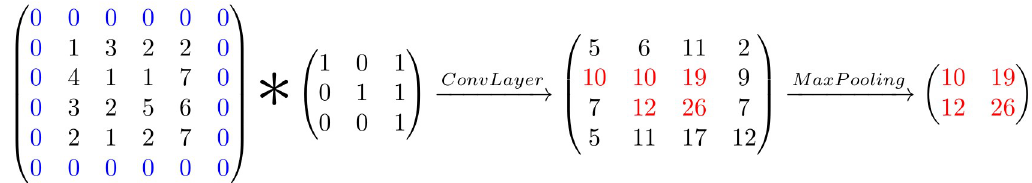
Fig 6. Convolutional layer with zero-padding and a 3 × 3 filter followed by max pooling with a 2 × 2 block.